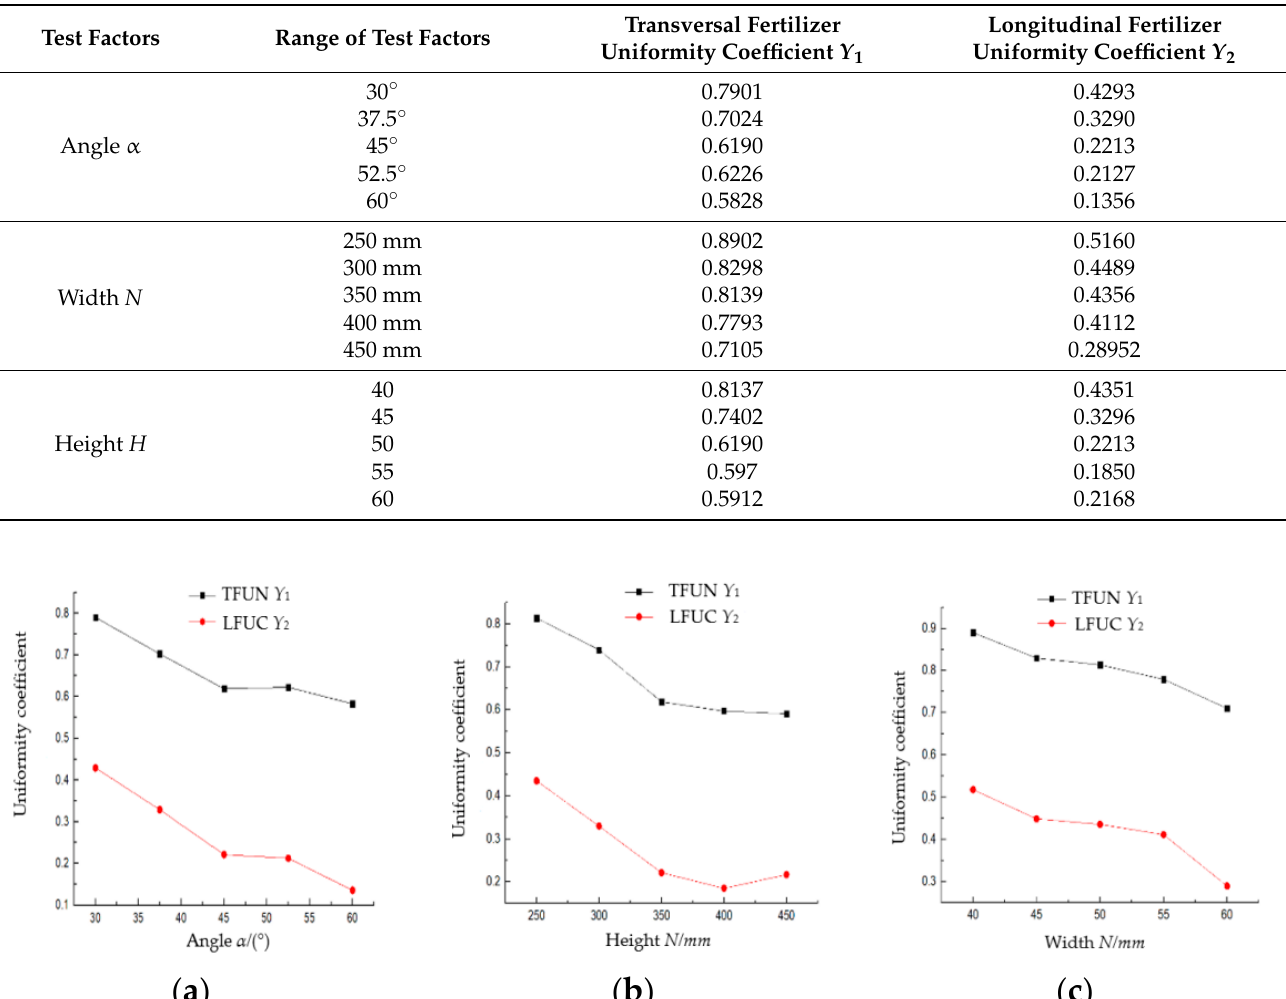
Table 2. Single factor test results of swing angle, height, and width. Figure 8. Schematic diagram of fertilizer monitoring area.